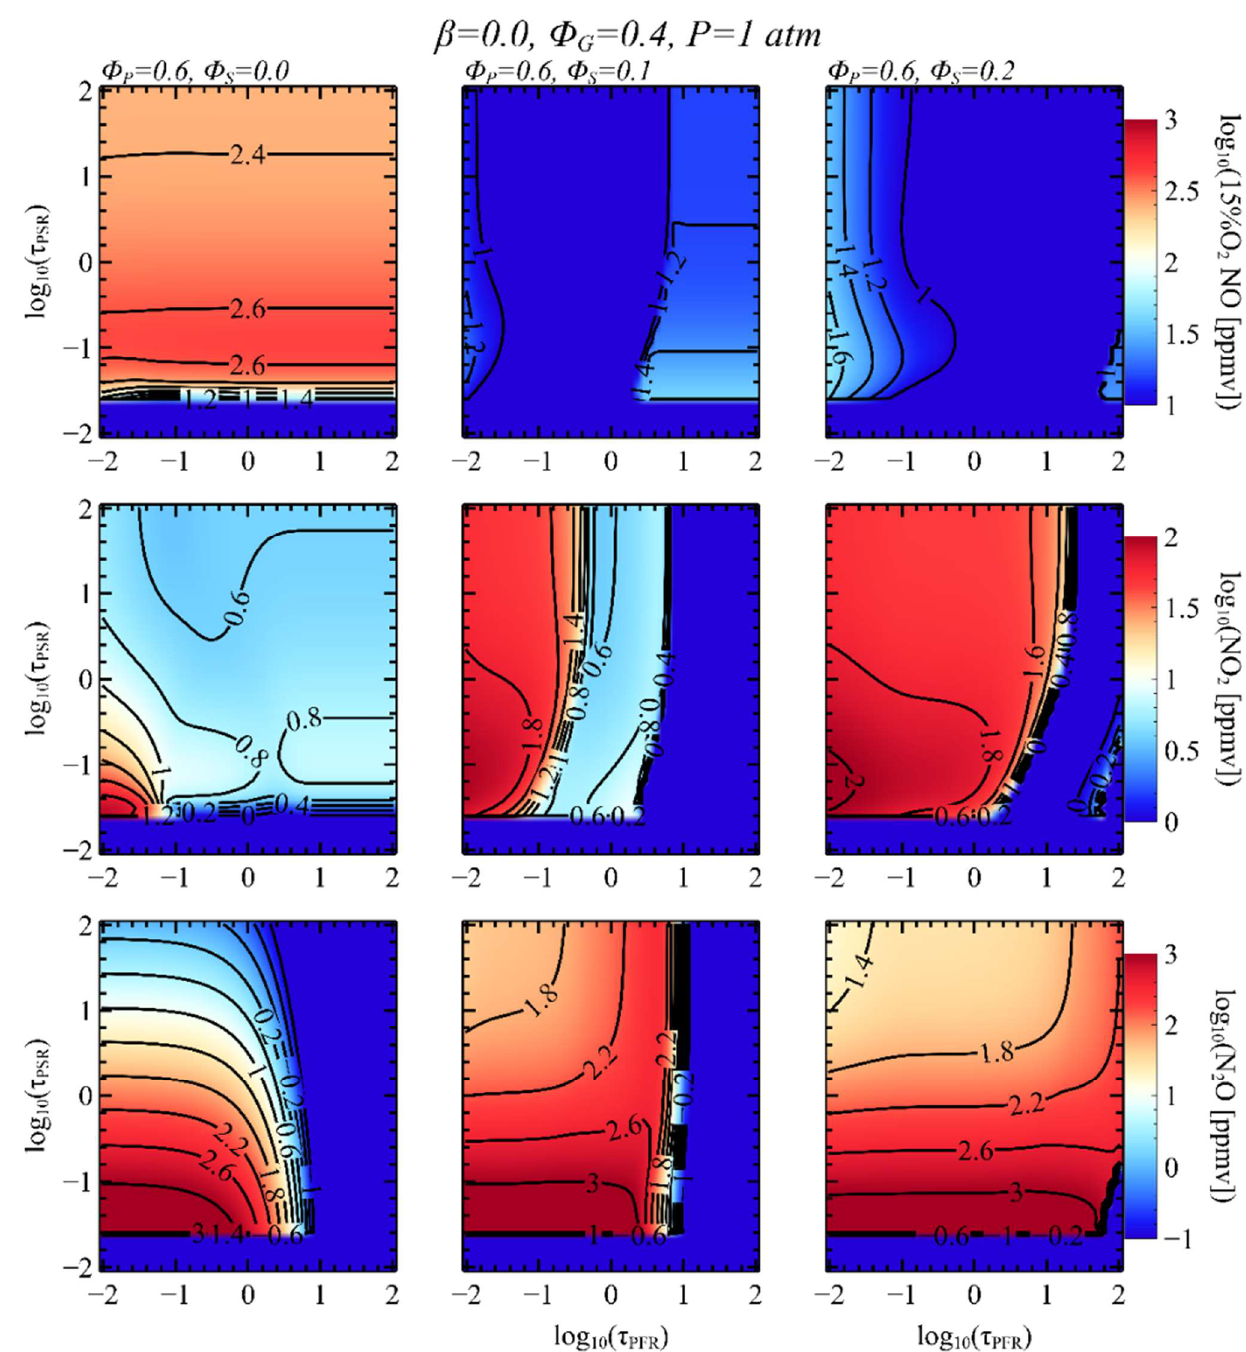
Figure 5. Contour maps of NOx emission in FS CRN. Each column represents computational results with different φ p and φ s